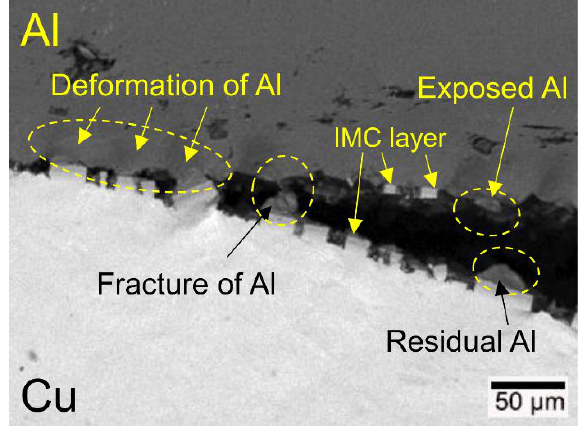
Figure 14. The cross section image (BSE image) of the fractured clad sheet with the rolled thickness of 5